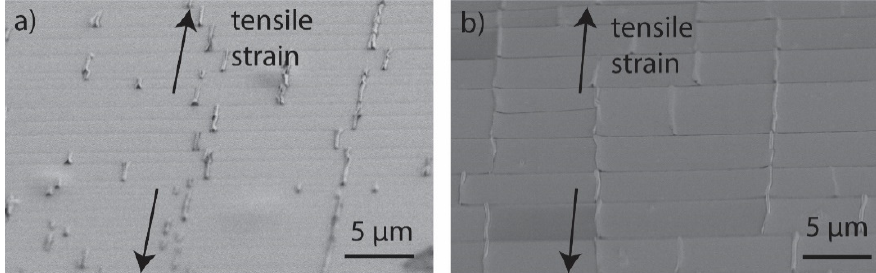
Figure 4. Scanning electron microscope (SEM) overview of the fractured samples after tensile straining up to 12% showing the channel cracks and the transverse buckles/crack owing to lateral contraction. ( a ) ZnO on polyimide from a 55° angle and ( b ) Al 2 O 3 deposited at 155 °C on polyimide from a 52° angle.